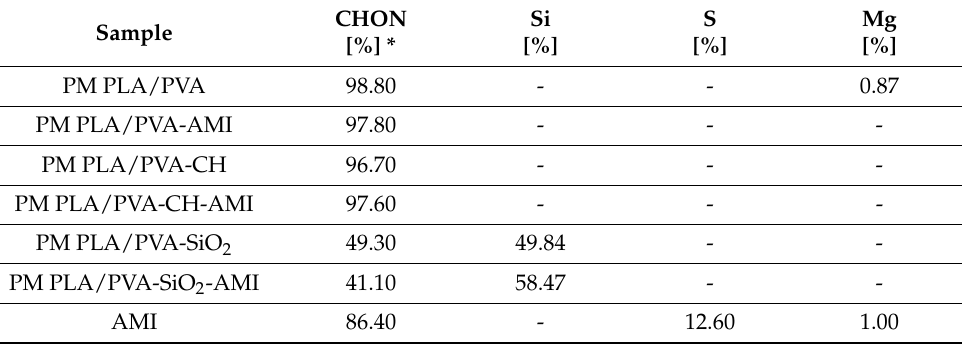
Table 1. Results of the elemental analysis (EDXRF) of the materials in the form of porous